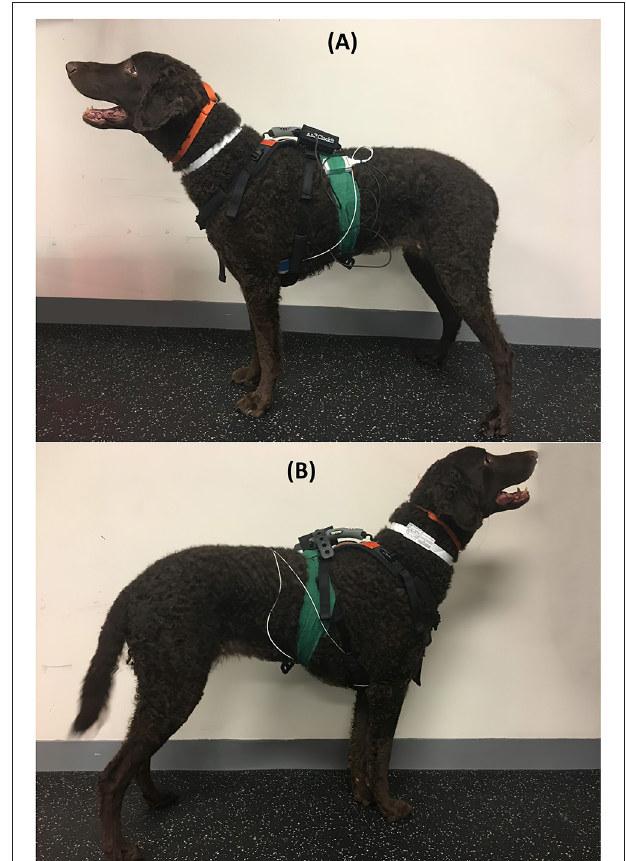
FIGURE 1 | Dog equipped with both the HOLTER and HR MONITOR monitors from the left side (A) , where both the HOLTER and HR MONITOR monitors have pads, and from the right side (B) , where only HOLTER has pads.